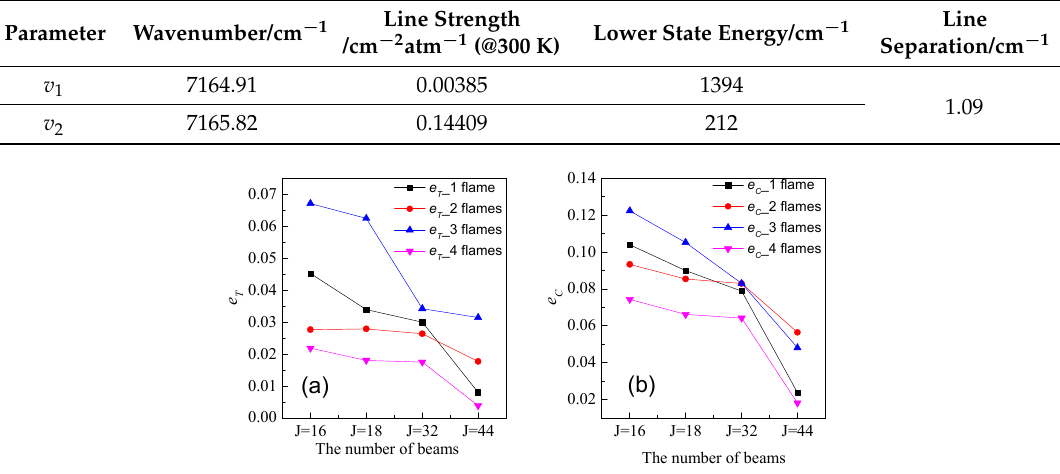
Figure 6. ( a ) The mean relative errors of temperature on the different number of beams. The e T _1 flame, e T _2 flames, e T _3 flames, and e T _4 flames are the temperature mean relative errors within one, two, three, and four flames. ( b ) The mean relative errors of H 2 O concentration on the different number of beams. The e C _1 flame, e C _2 flames, e C _3 flames, and e C _4 flames are the H 2 O concentration mean relative errors within one, two, three, and four flames.